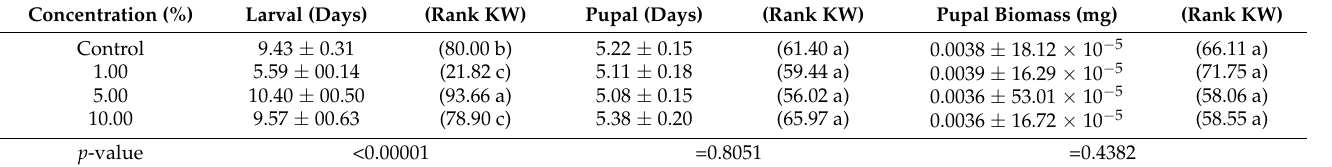
Table 1. Duration (mean ± SE) and nonparametric ranking of the larval and pupal stages of P. xylostella exposed to different M. albicans extract concentrations.